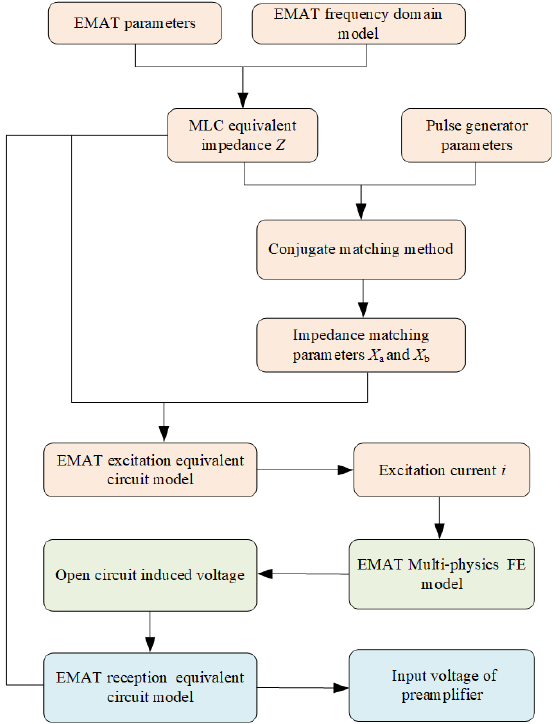
Figure 5. Circuit-field coupled FE modeling detection process of angled SV wave EMAT.